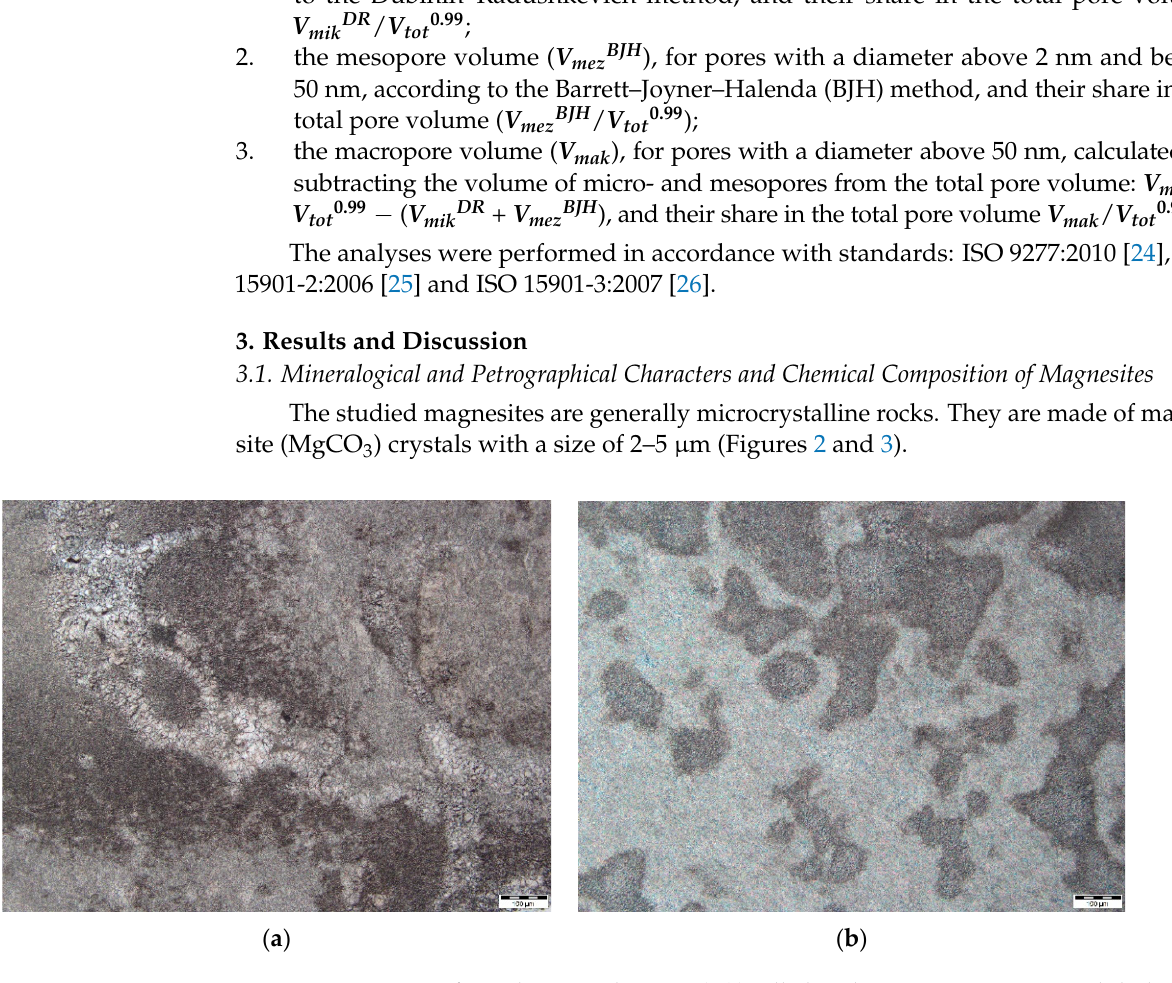
Figure 2. Magnesite from the Wiry deposit. ( a , b ) Filled with magnesite cement and dark areas pigmented with iron compounds.